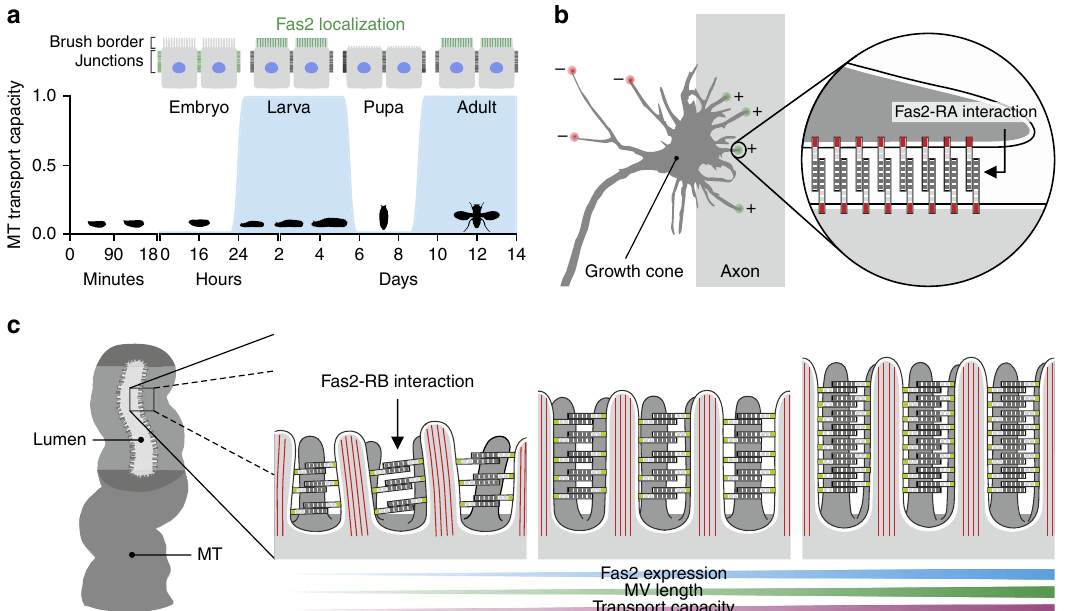
Figure 6 | Hypothesis for Fas2 function in the Drosophila MT. ( a ) Schematic representation of the spatio-temporal expression pattern of Fas2 (green) during tubule development. Fas2 does not localize to the microvilli when the tubules are transport incompetent, but are abruptly recruited to the microvillar brush border when the tissue develops transport competence (blue). ( b ) Schematic representation of how Fas2 is proposed to provide attractive forces through homophilic adhesion on the axon relative to the environment that promotes axon fasciculation and growth cone guidance (based on ref. 11). ( c ) Proposed model for Fas2 function in the adult Drosophila MT. By contrast to the Drosophila nervous system and neuromuscular junction, where Fas2 mediates intercellular interactions, we hypothesize that Fas2 acts as homotypic bridging protein within the same cell of the renal tubule, where it stabilizes the microvillar brush border against shear stress caused by uniquely high flux rates. Knockdown of Fas2 results in shorter and disorganized microvilli with the opposite being the case when Fas2 is